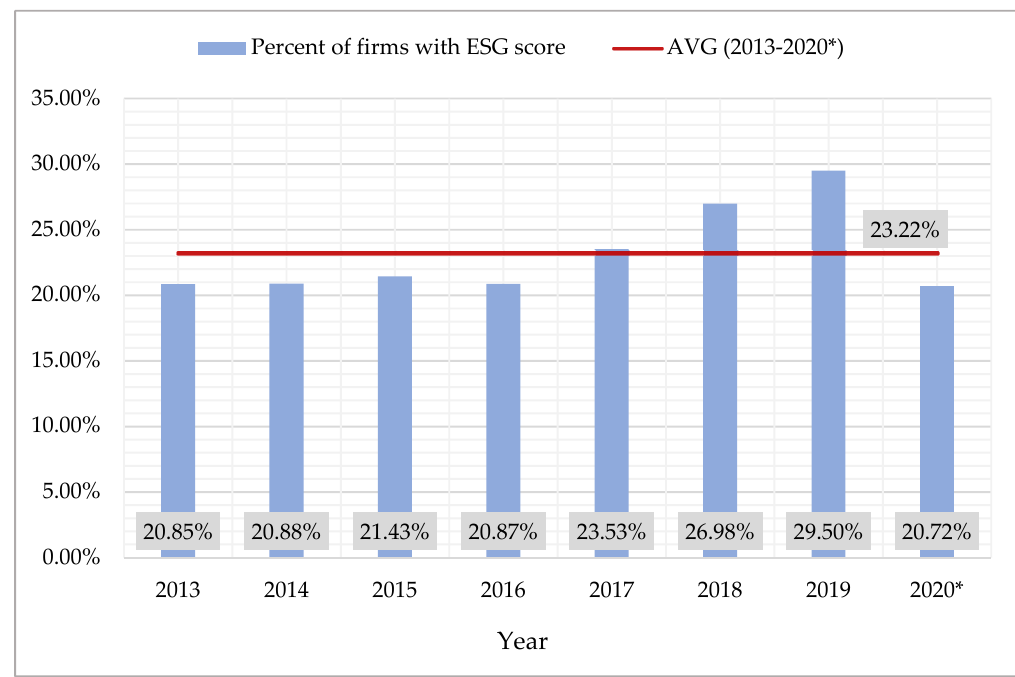
Figure 1. Sample composition—percentage of European energy sector firms that are rated with an ESG score. Notes: * data requested as of end of July 2021, thus the number of observations for 2020 is illustrative, as it gives the mid-term effects (see explanation in notes to Table 1).